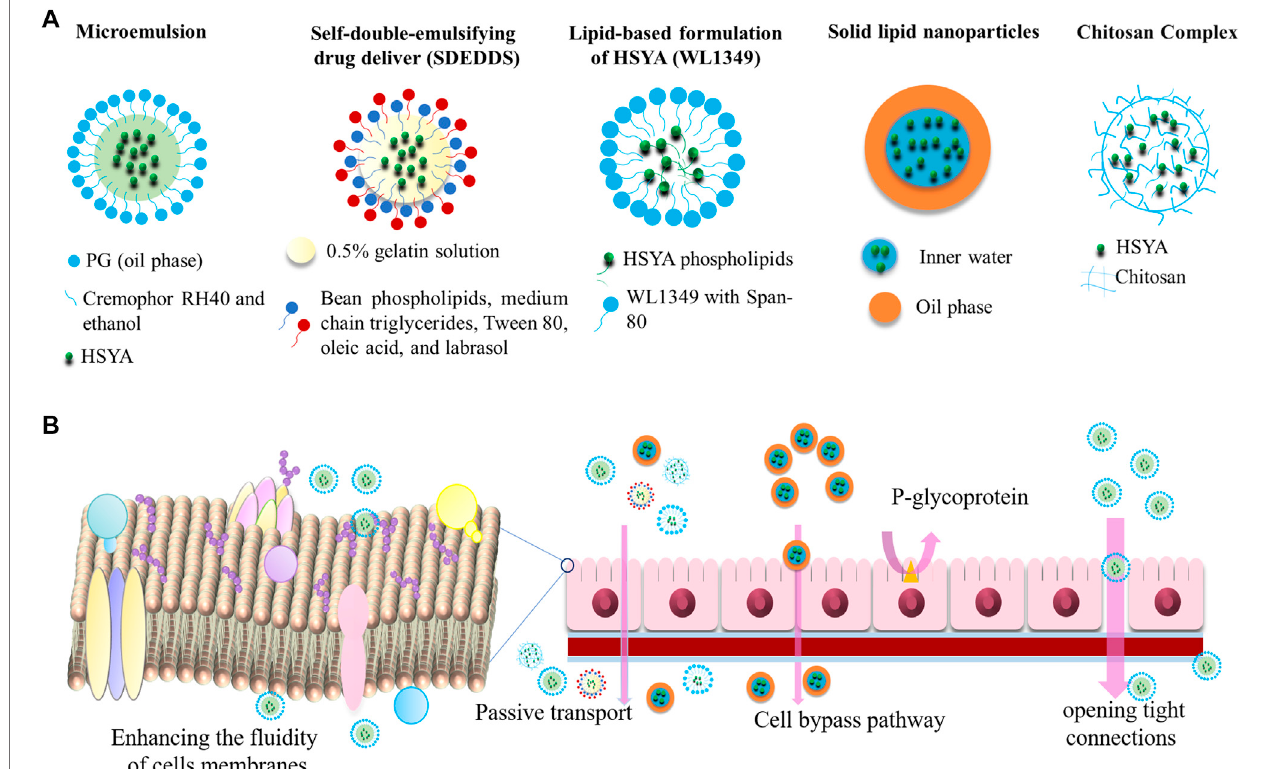
FIGURE 7 | Schematic representation of the different kinds of colloidal delivery systems.